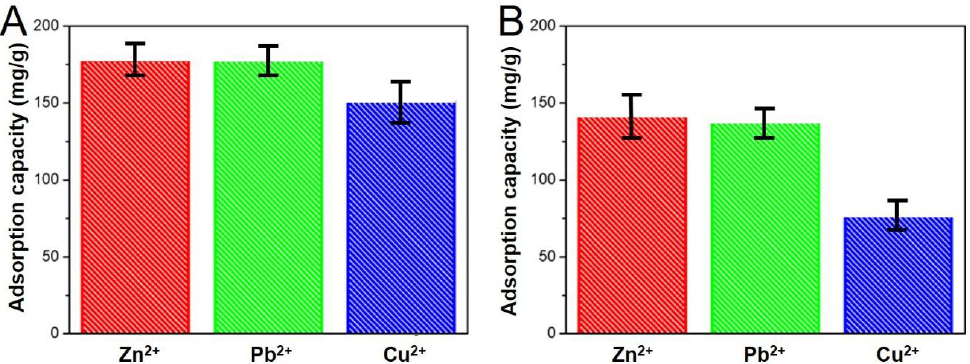
Figure 9. The adsorption of Pb 2+ and Cu 2+ on MnO 2 @PSS/PDDA/PSS in a single system ( A ) and ternary system ( B ).